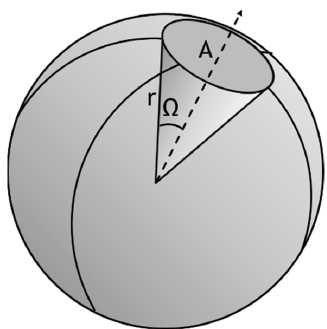
Figure 4. Projection of a cone onto a sphere.